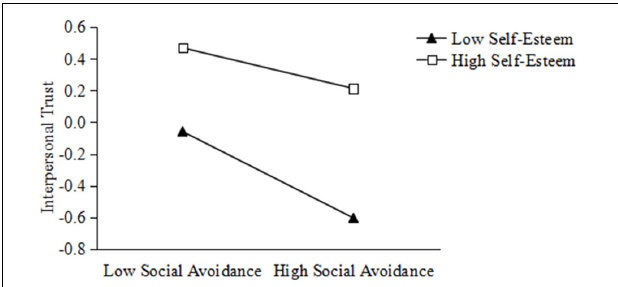
FIGURE 2 | The regulatory effects of self-esteem on the relationship between social avoidance and interpersonal trust.